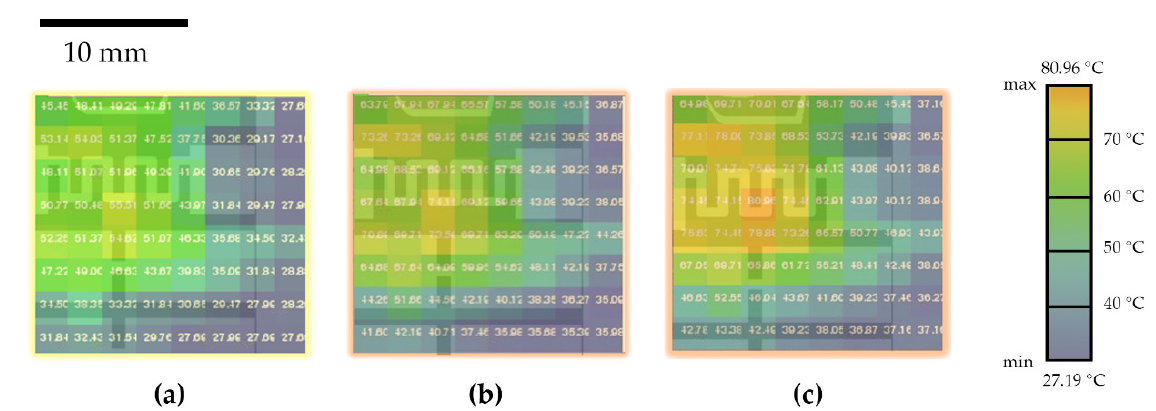
Figure 4. Image capture of the thermal camera with an applied voltage of ( a ) 2 V (peak temperature of 55.51 °C), ( b ) 2.5 V (peak temperature of 74.15 °C), and ( c ) 3 V (peak temperature of 80.96 °C).